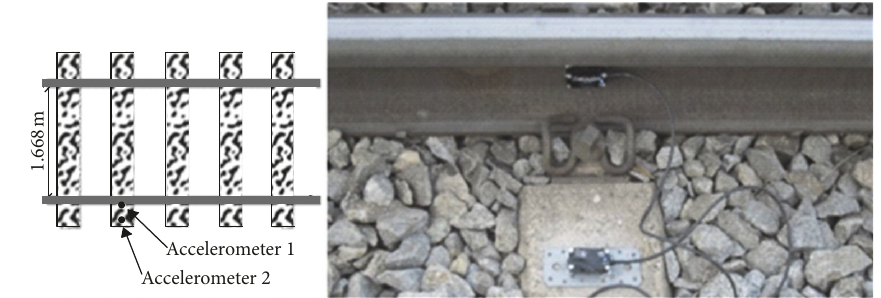
Figure 5: Field instrumentation arrangement for the gathering campaign.